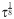
A: Stationary pattern solutions, u (green) and v (red), obtained by our theoretical approach (continuous lines) and in numerical simulations (dotted lines). Parameters: a = 0.9, Dv = 9 (black circle in Fig 1A). B: Pattern amplitudes as a function of the nonlinear parameter, τ, for different values of p and r (log-log axes): p = 3 and r = 2 (circles), p = 3 and r = 0 (triangles), and p = 5 and r = 4 (squares). The symbols stand for numerical results and the colored lines for the analytical solutions: p = 3 and r = 2 (solid line), p = 3 and r = 0 (dotted line), and p = 5 and r = 4 (dashed line). The black solids lines are a guide to the eye and show, from top to bottom, the functions τ18, τ14, and τ12. The insets show the relative importance of the first order correction versus the leading order of the expansion by plotting τδz(1)δz(0) as a function of τ (lines codes as in the main figure). C: Quantification of the relative error, Δz, as a function of different combinations of the values of the exponents p, r, s, and t (the rest of parameters as in panel A). The scale bar (right) is the same for all density plots.